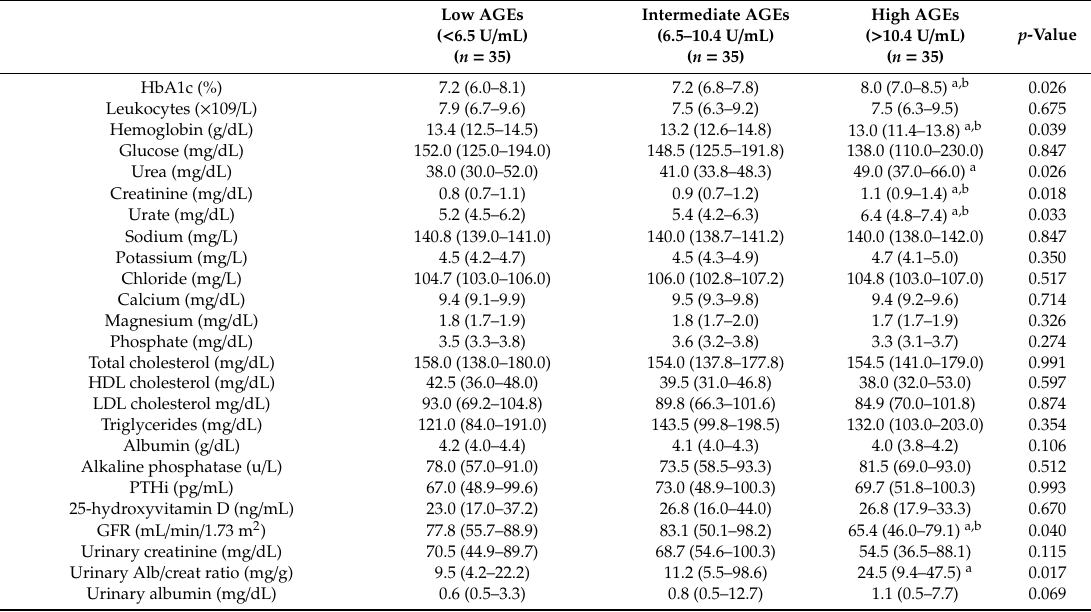
Table 2. Laboratory parameters among AGEs